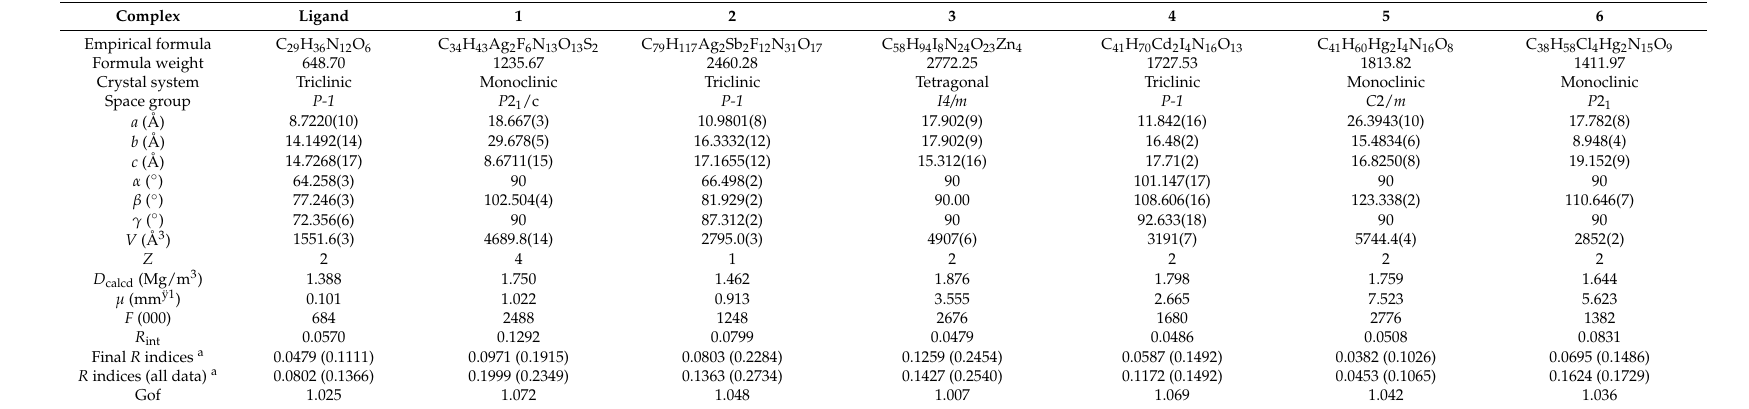
Table 2. Crystal data for 1 – 6